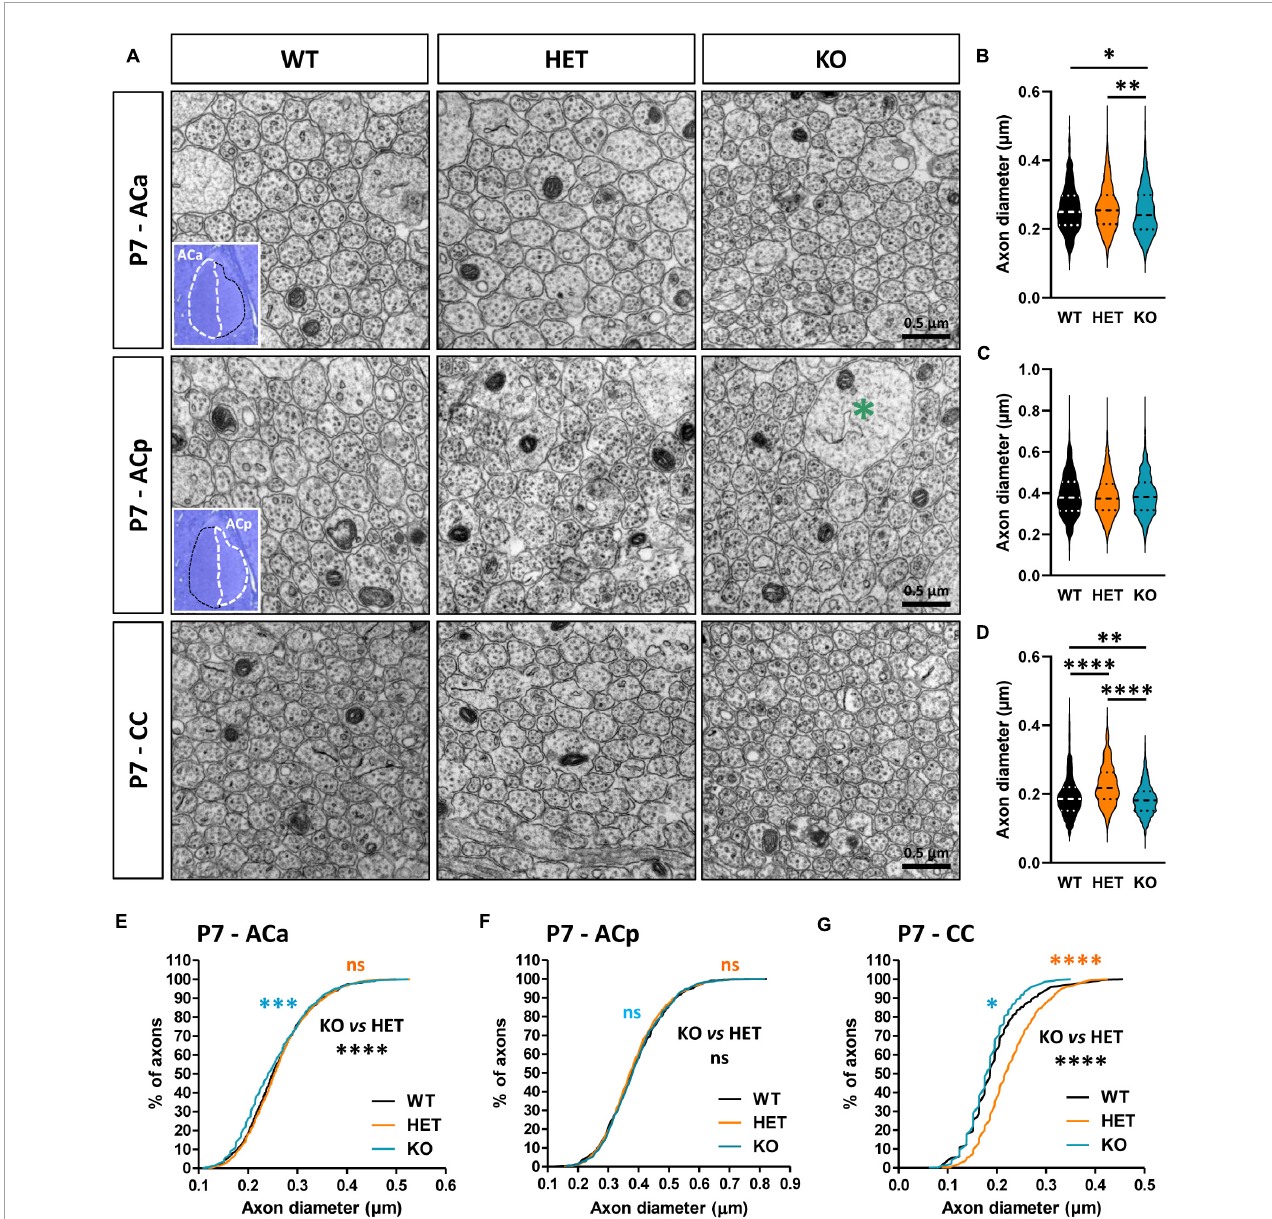
FIGURE6 Anterior commissure (AC) and corpus callosum (CC) axon diameter abnormalities in P7 pups. Electron micrographs of transversal sections of the anterior branch (ACa), posterior branch (ACp), and CC at brain midline, from wild-type (WT), HET, and KO P7 pups; insets, semi-thin transversal sections of the AC stained with toluidine blue, showing the ACa and the ACp; the green asterisk indicates a growth cone (A) . Axonal diameters of the ACa (B) , ACp (C) , and CC (D) . Cumulative frequency distribution of axonal diameters (in %) of the ACa (E) , ACp (F) , and CC (G) . (B,C,E,F) 900 axons/genotype, 3 pups/genotype, 300 axons/pup; (D,G) 1080 axons/genotype, 3 pups/genotype, 360 axons/pup. Statistical tests: (B–D) Mann–Whitney test to compare HET or KO mice to WT mice, and Kruskal–Wallis test to compare the three genotypes; (E–G) Kolmogorov–Smirov test for pairwise comparisons; ∗ P < 0.05, ∗∗ P < 0.01, ∗∗∗ P < 0.001, ∗∗∗∗ P < 0.0001; ns,